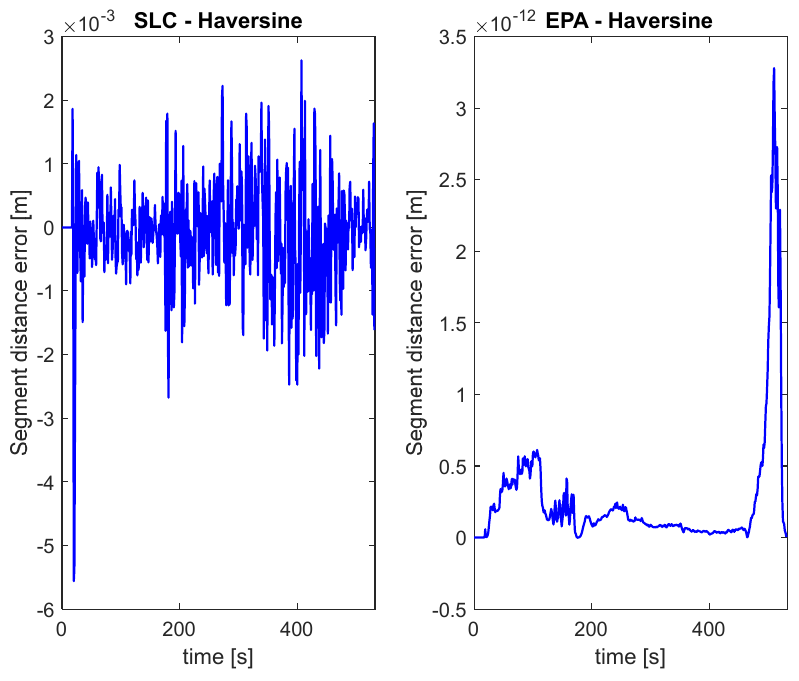
Figure 6. Results of distance calculations with different methods compared.